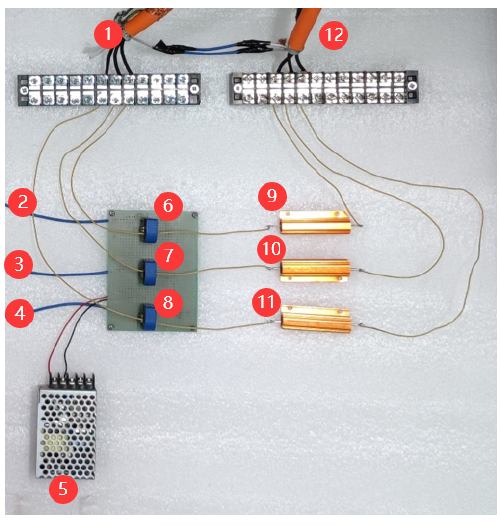
Figure 16. Failure testing of PMSM.